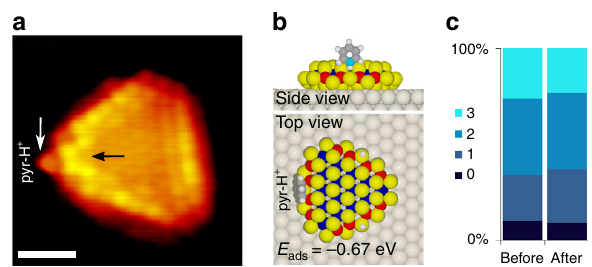
Fig. 6 Pyridine adsorption on r- CoMoS. a Atom-resolved STM image of an r -CoMoS nanocluster ( V = − 0.71 V, I = − 0.60 nA) after dosing pyridine t t at 300 K. Scale bar is 1 nm. b Calculated ball model for the most stable adsorption con fi guration of pyr-H + on an r -CoMoS S-edge. The formation of pyr-H + is crucial for adsorption as no stable non-protonated pyridine adsorption modes were found (see Supplementary Figure 9). Color code as previous fi gures, N: cyan. c Average distribution of quenched edges per cluster based on a cluster count for r -CoMoS before and after pyridine dosage (0 = no quenched edges, 3 = all widely used in IR-spectroscopy as a probe for Brønsted acidity and used previously to investigate S – H groups on sul fi des 32 .